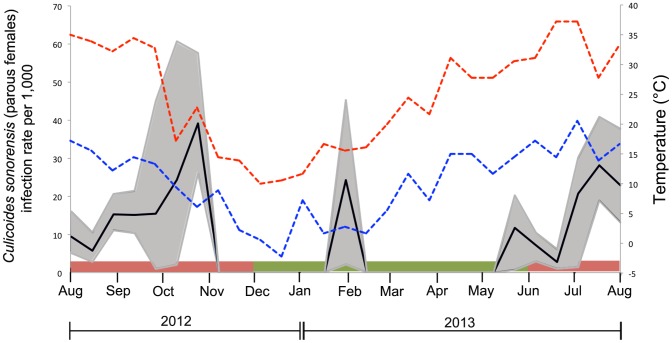
Seasonal patterns of BTV infection among parous female C. sonorensis midges and sentinel cattle collected on a dairy farm during the period of August 2012-August, 2013.The point estimate (solid line) of infection rate per 1,000 tested Culicoides; 95% confidence intervals (shaded region); maximum temperature (°C - red dash line); minimum temperature (°C – blue dash line). Shaded regions at the base of the graph are representative of historically described seasonal (red shading) and interseasonal (green shading) periods of infection.